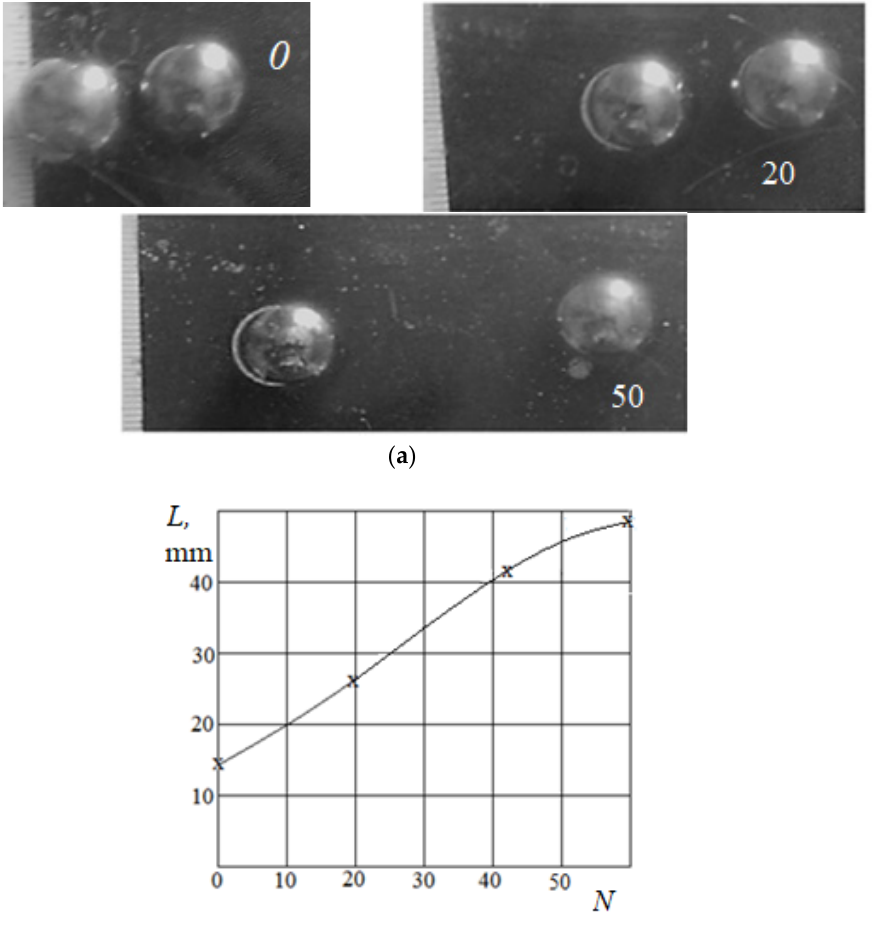
Figure 7. Effect of ball separation ( a ), evolution of the distance between the ball centers ( b ). N is the number of cycles.